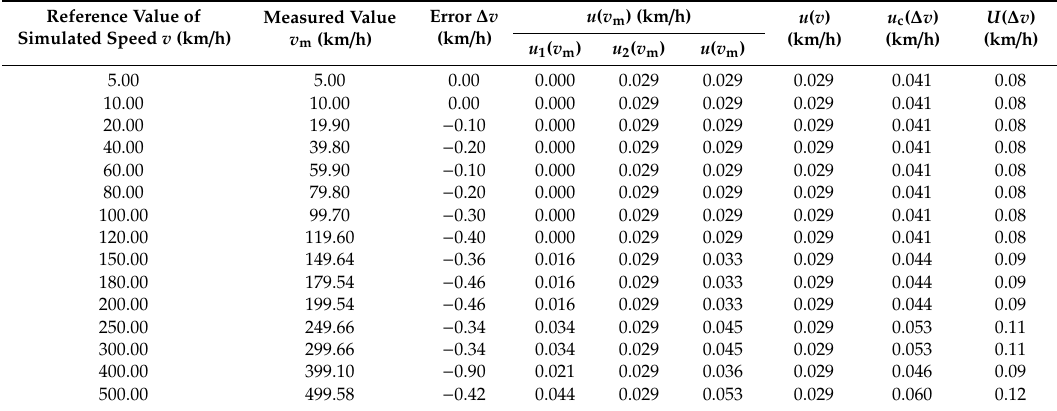
Table 13. Uncertainty evaluation results of the DRS05S1c